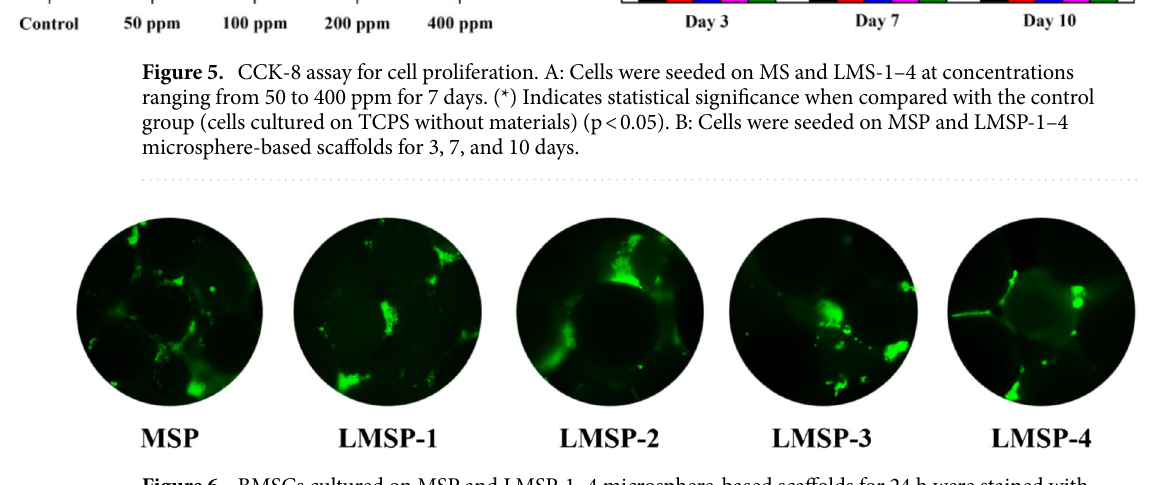
Figure 6. BMSCs cultured on MSP and LMSP-1–4 microsphere-based scaffolds for 24 h were stained with Live/Dead Cell Staining Kit to evaluate the viability of cells implanted on scaffolds.